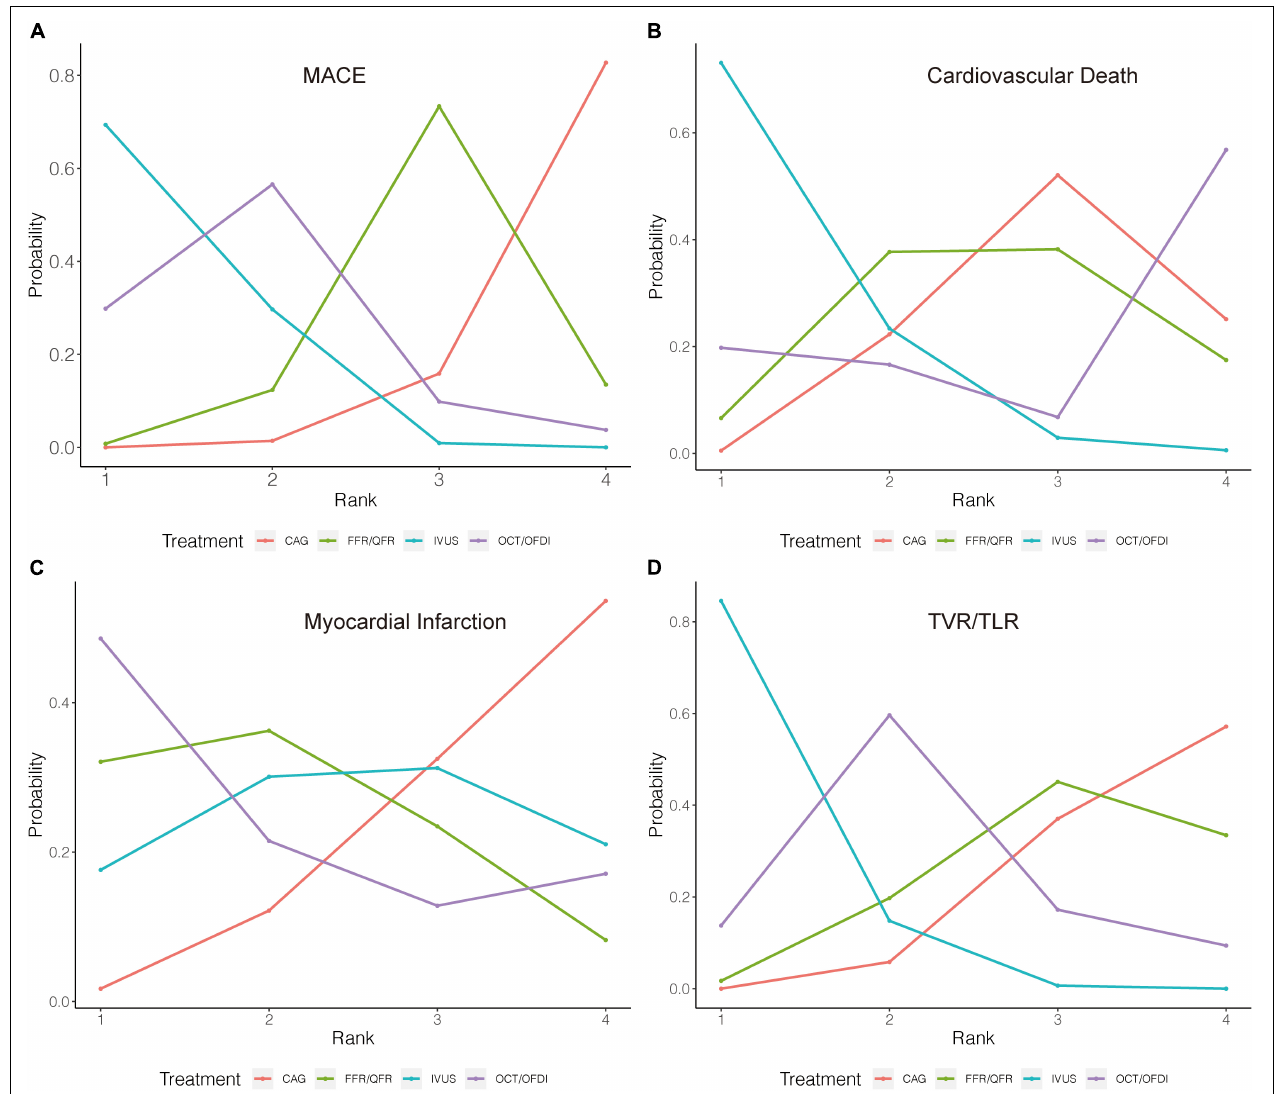
FIGURE 3 | Rank probability analysis for primary outcomes among guidance modalities included in the network meta-analysis. Rank 1 is the best while rank 4 is the worst. For example, for MACE (A) , IVUS had the highest probability of ranking 1, CAG had the lowest probability of ranking 1. CAG, coronary angiography; FFR, fractional flow reserve; IVUS, intravascular ultrasound; OCT, optical coherence tomography; OFDI, optical frequency domain imaging; QFR, quantitative flow ratio. (A) Major adverse cardiovascular events. (B) Cardiovascular death. (C) Myocardial infarction. (D) Target vessel revascularization/target lesion